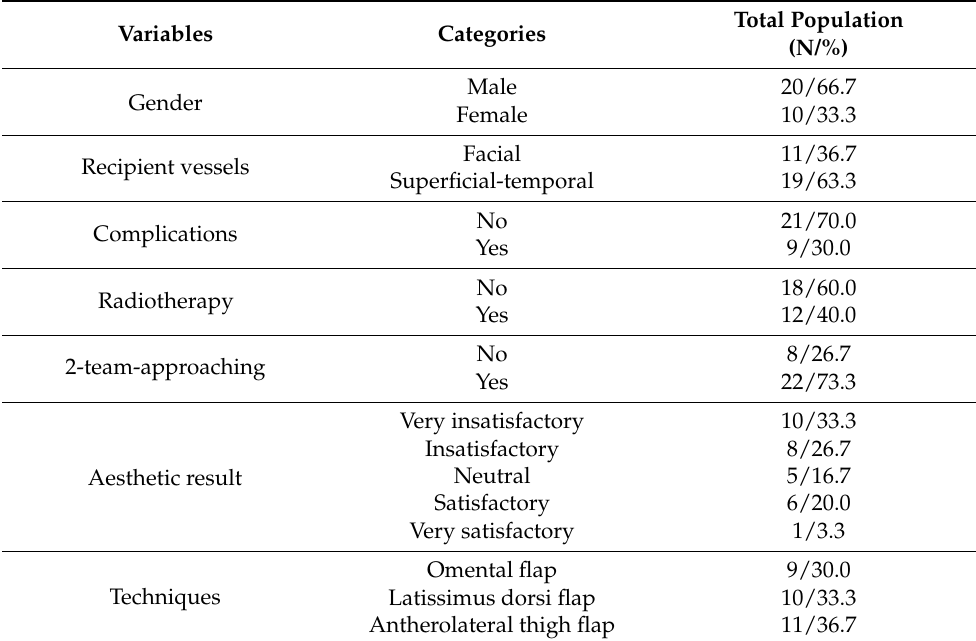
Table 2. Descriptive categorical variables in total study population.